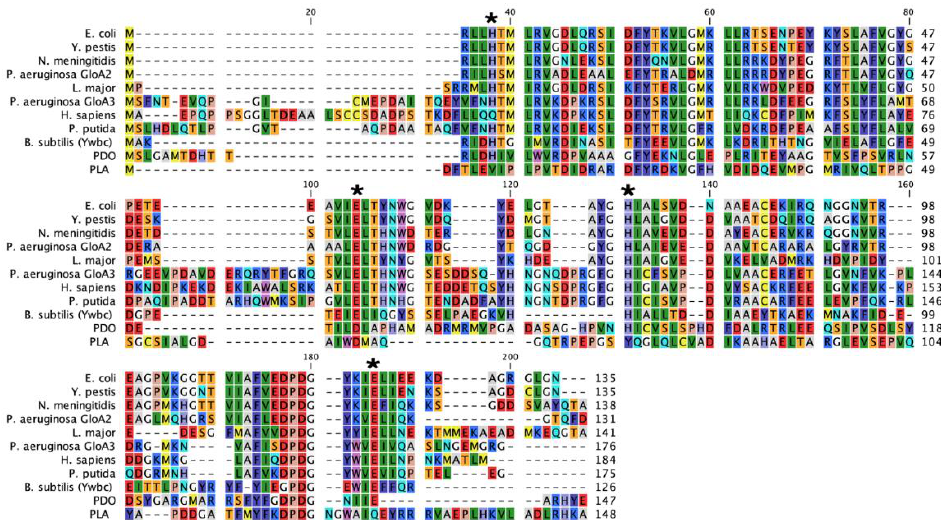
Figure 5. The multiple sequence alignment of the putative dioxygenase (PDO, CAC42744) and the putative lyase (PLA, CAC37263) from Streptomyces coelicolor A3(2) with glyoxalase I from other organisms (organism name followed by National Center for Biotechnology Information (NCBI) accession number), including E. coli (NP_310387), Y. pestis (ZP_01887743.1), N. meningitides (CAA74673), P. aeruginosa GloA2 (ATE47122.1), L. major (AAT98624.1), P. aeruginosa GloA3 (AAG08496.1), H. sapiens (AAB49495), P. putida (AAN69360), B. subtilis bacillithiol-dependent MG resistance proposed Glo1 (P39586.1). The metal-binding residues are highlighted with asterisks. Three di ff erent Glo1 have been identified in P. aeruginosa PA01: GloA1 (Ni 2 + -activated), GloA2 (Ni 2 + -activated and GloA3 (Zn 2 + -activated) [68]. The alignment was created using CLC Main Workbench (version 8.1.2) with